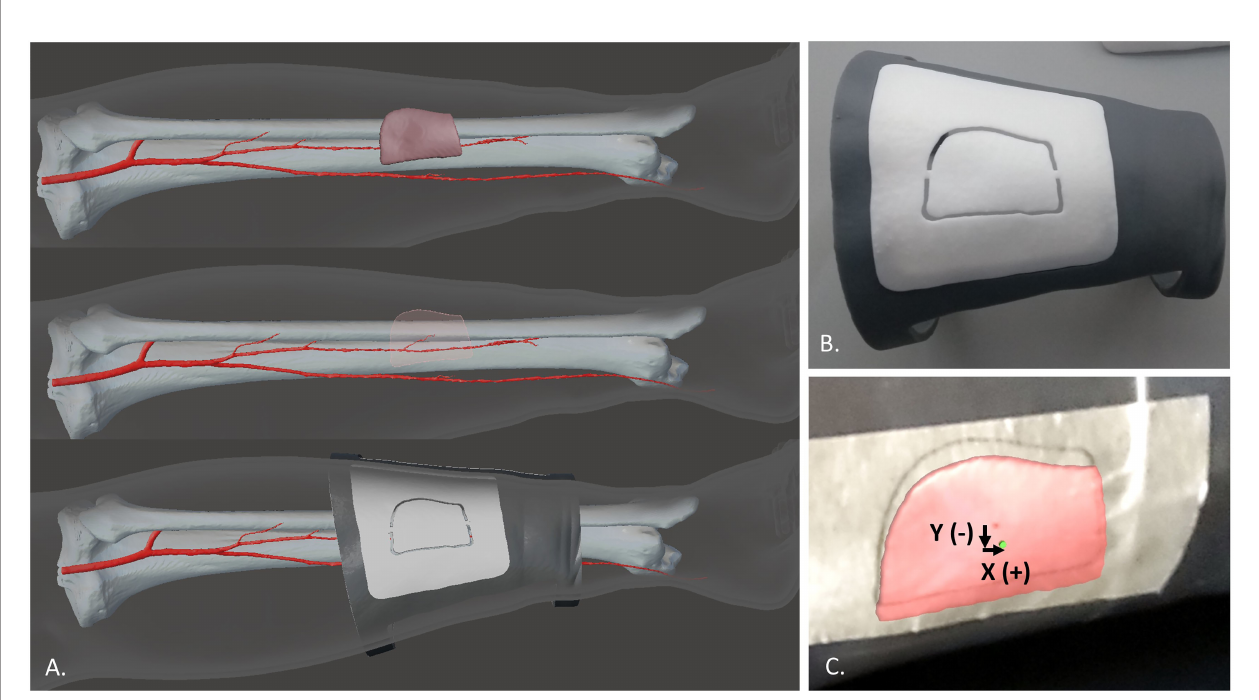
FIGURE 6 | The virtual planning of the skin paddle outline centering the perforator (A) and the CAD/CAM template used to transfer this planned skin paddle pro fi le to the 3D printed phantom (B) . Comparison between the virtual paddle projected in AR and the real one obtained from the CAD/CAM template applied to the leg phantom (C)